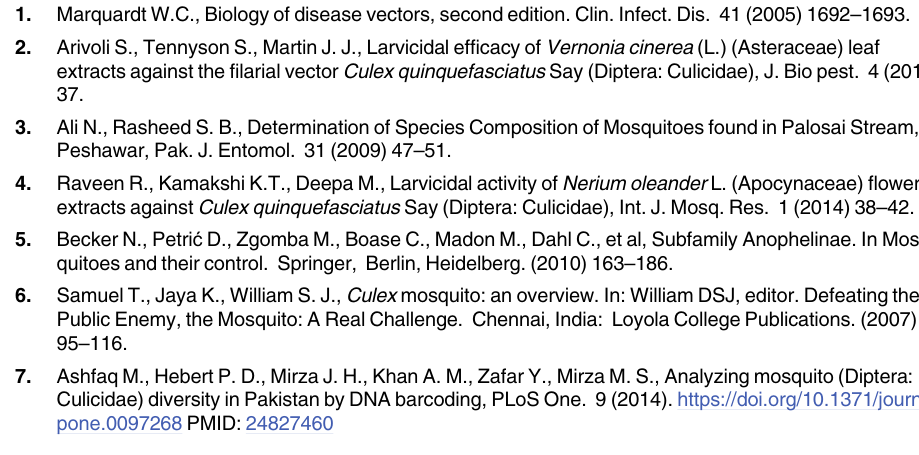
S1 Table. Summary of different qualitative phytochemical tests conducted for the analysis of M . piperita . S2 Table. Preliminary different quantitative phytochemical tests showed for the study of M . piperita . S3 Table. Three way ANOVA of different hours of exposure, plant and concentrations as variables. S4 Table. UV-Vis peak values of ethanol extract of M . piperita . S5 Table. Phytochemicals identified in ethanolic leaves extract of M . piperita by GC-MS peak